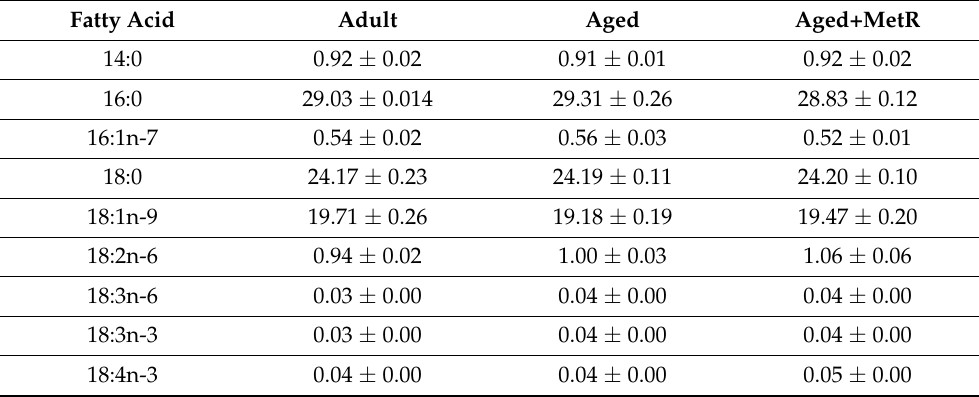
Table 6. Fatty acid composition of total lipids in the rat frontal cortex